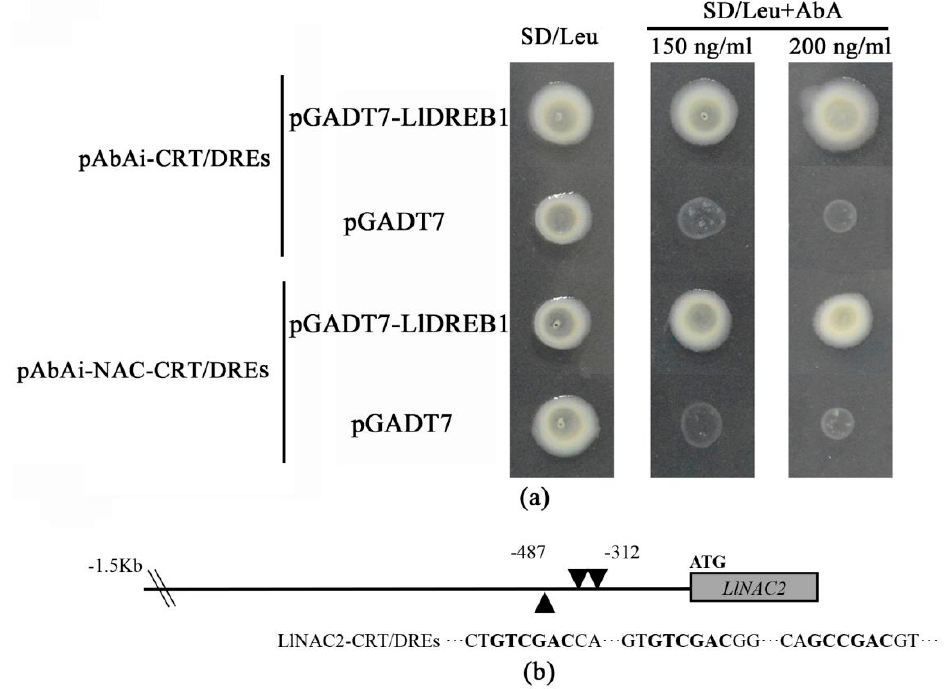
Figure 5. Yeast one-hybrid analysis of LlDREB1 binding to LlNAC2 promoter. ( a ) Yeast one-hybrid analysis. Three tandem repeats of a CRT / DRE and the − 487 to − 312 region of the LlNAC2 promoter were inserted in front of the reporter gene AUR1-C. Yeast strain Y1HGold was co-transformed with bait (pAbAi-CRT / DREs or pAbAi-NAC-CRT / DREs) and a prey (pGADT7 or pGADT7-LlDREB1) construct. Interaction between bait and prey was determined by cell growth on SD medium lacking Leu in the presence of 200 ng mL − 1 AbA. ( b ) Schematic representation of CRT / DRE recognition elements in the LlNAC2 promoter.